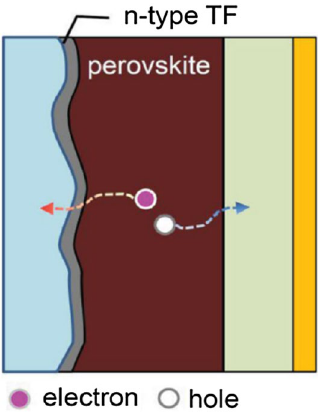
Fig. 2 Schematic diagram of working principle for PSC